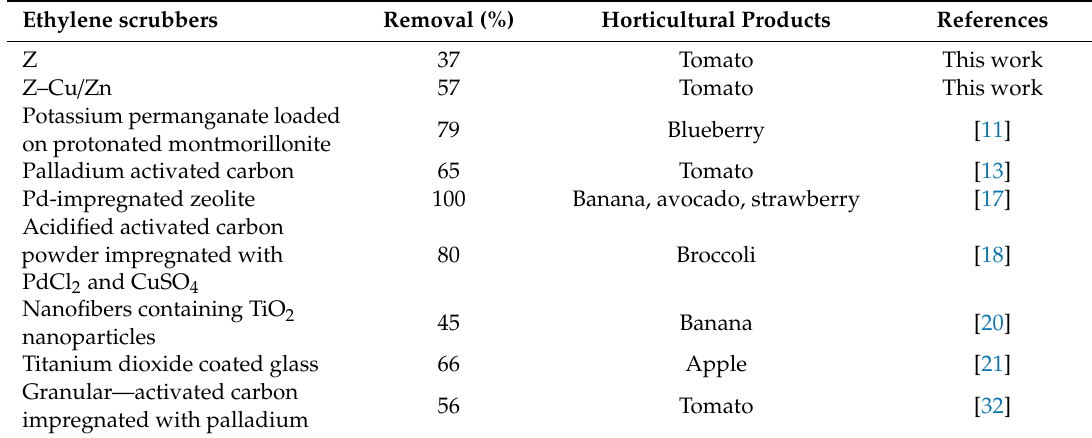
Table 2. Comparison of the removal of ethylene using natural (Z) and modified natural zeolite doped with copper and zinc (Z–Cu / Zn) to some other ethylene scrubbers reported in the